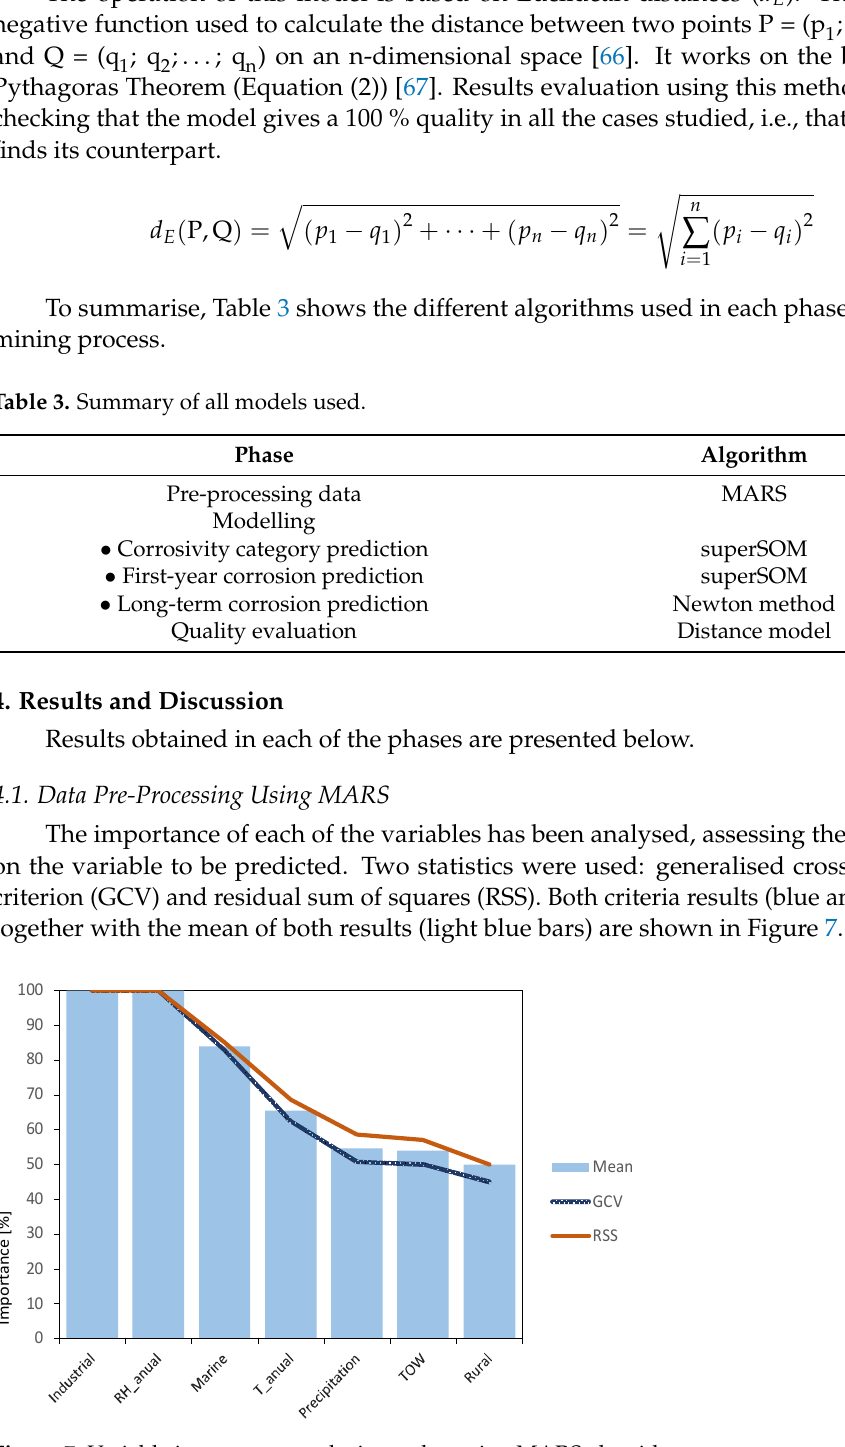
Figure 7. Variable importance analysis results, using MARS algorithm.